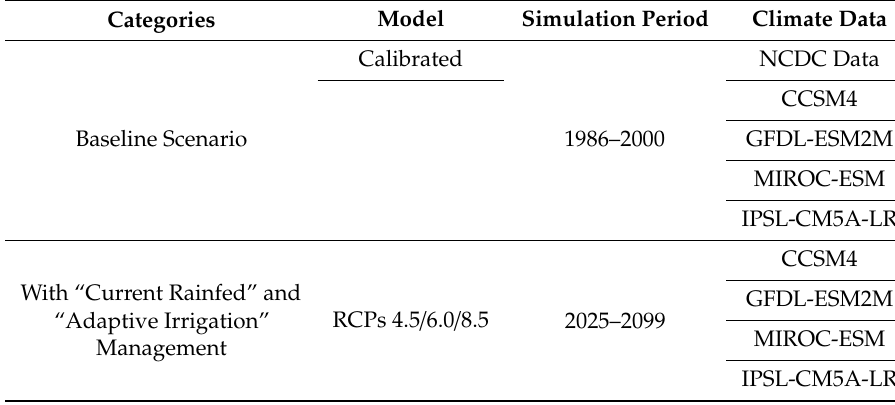
Table 5. Evaluation criteria for calibration and validation performance for the hydrologic model. Adapted from Moraisi et al.